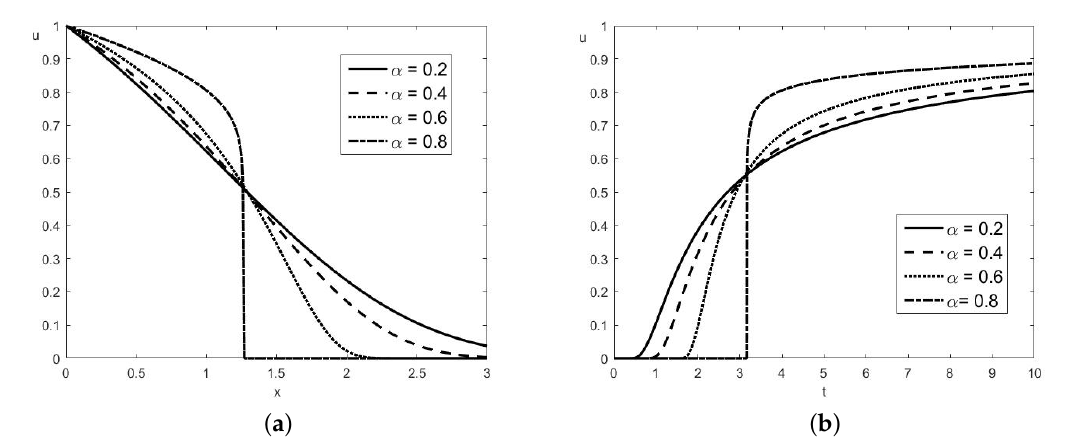
Figure 1. Velocity field u ( x , t ) for β = 0.8 and different values of α : 0.2,0.4,0.6, and 0.8; a = 10 α ,